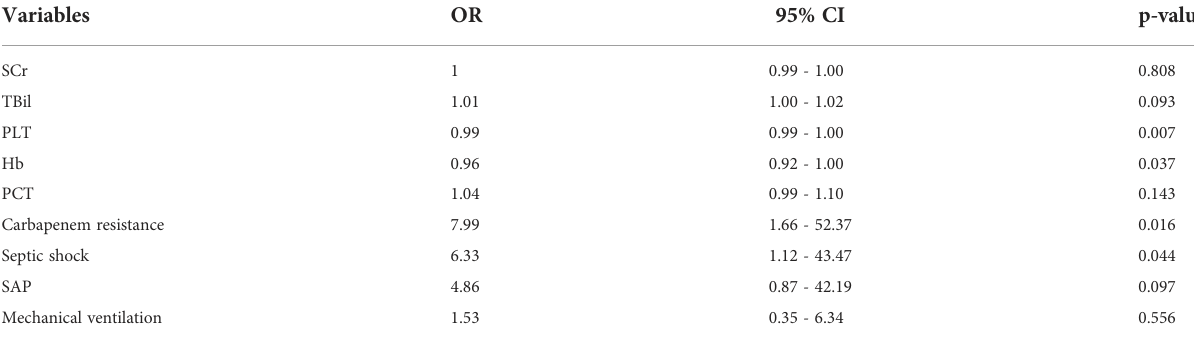
TABLE 3 Multivariate logistic regression analysis of mortality based on baseline characteristics in the survival group and death group.